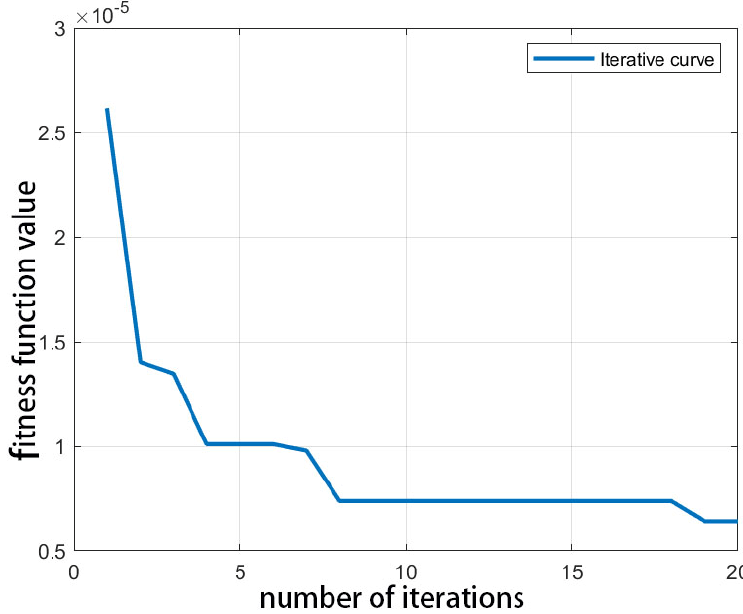
Figure 5. Iteration curve of IWOA optimized RANSAC algorithm.